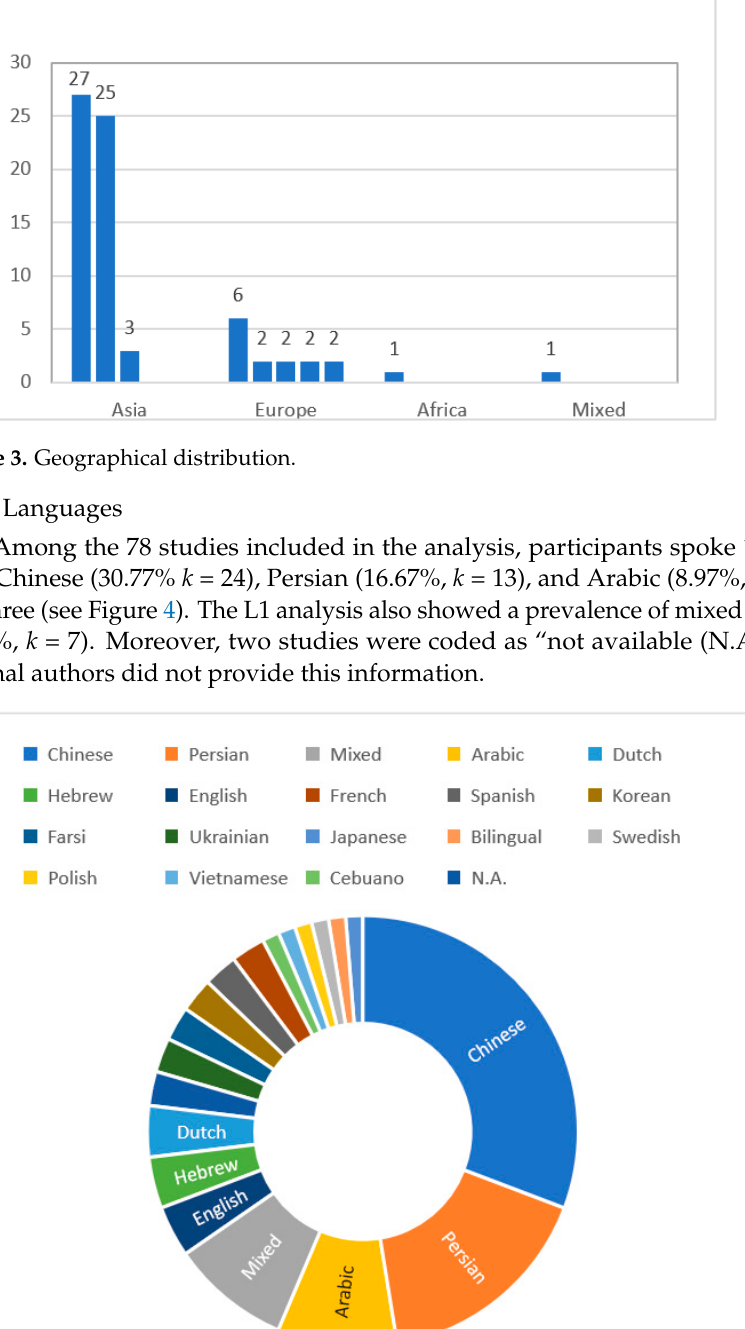
Figure 4. The L1 Backgrounds.